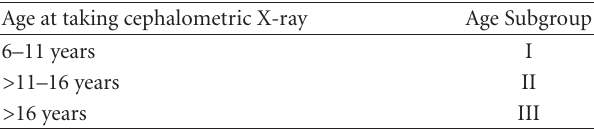
Table 1: Definition of subgroups based on age.